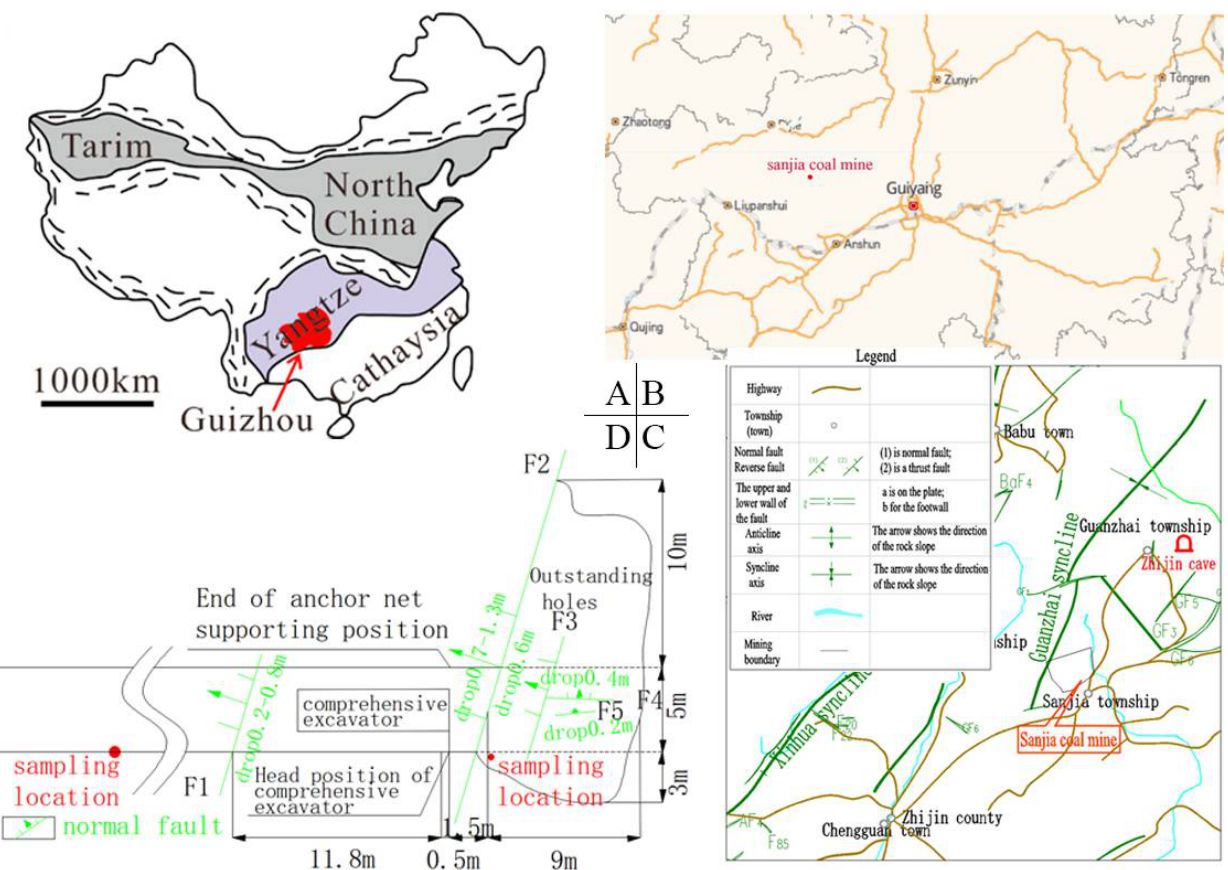
Figure 1. Prominent position diagram. Note: ( A , B ) are the geographical location of the mine; ( C ) is the geological structure near the mine; ( D ) is a prominent geological structure.